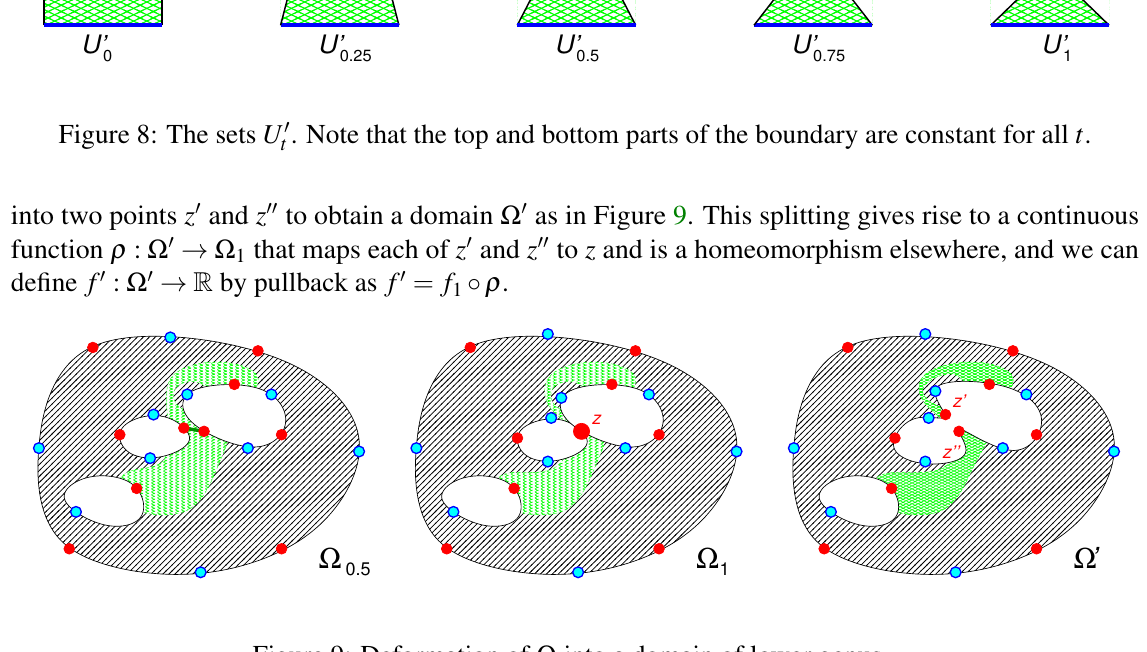
Figure 9: Deformation of Ω into a domain of lower